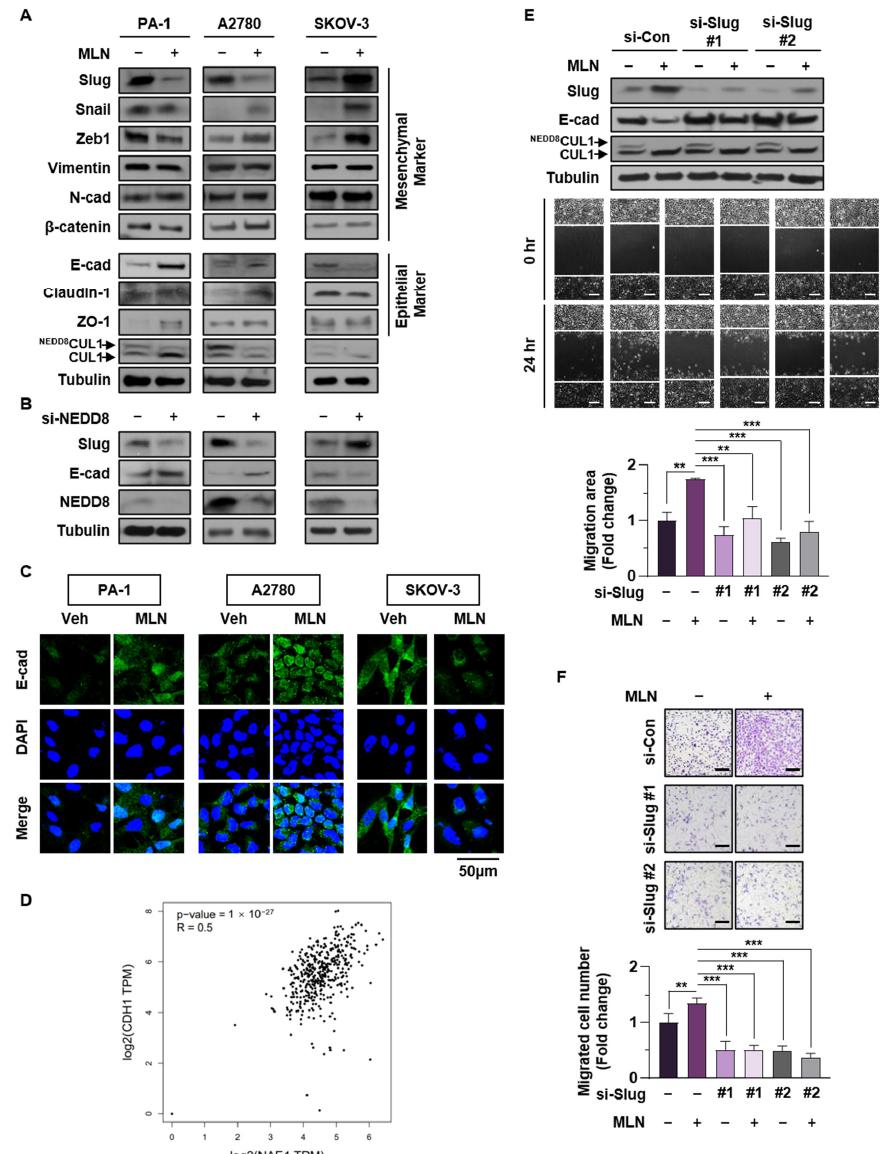
Figure 3. Slug plays a major role in regulating neddylation blockade-mediated EMT in cancer cells ( A , B ) PA-1, A2780, and SKOV-3 cells were treated with or without MLN4924 (125 nM) or transfected with si-Control or si-NEDD8. Protein levels of representative EMT markers were verified by western blot assays. ( C ) After cells had been treated with or without MLN4924 for 24 h in serum free medium, the expression of E-cadherin (green) was visualized by immunofluorescence. Scale bar: 50 μ m. The results shown are representative of three experiments with similar results. ( D ) Correlation between expression of NAE1 and CDH1 in ovarian cancer, analyzed using the GEPIA database. ( E ) SKOV-3 cells transfected with si-Control or si-Slug#1, 2 and/or treated with MLN4924 (125 nM) were subjected to wound healing assays. Cell lysates were then subjected to western blot assays to verify protein levels of Slug and E-cadherin. Scale bar: 200 μ m. Whole areas were measured using ImageJ software, and data are presented as the means ± standard deviation ( n = 3). ( F ) SKOV-3 cells transfected with si-Control or si-Slug#1, 2 and/or treated with MLN4924 (125 nM) were subjected to Transwell assay. The number of cells in four randomly chosen fields was counted. ** p < 0.01; *** p < 0.001; NS, not significant.